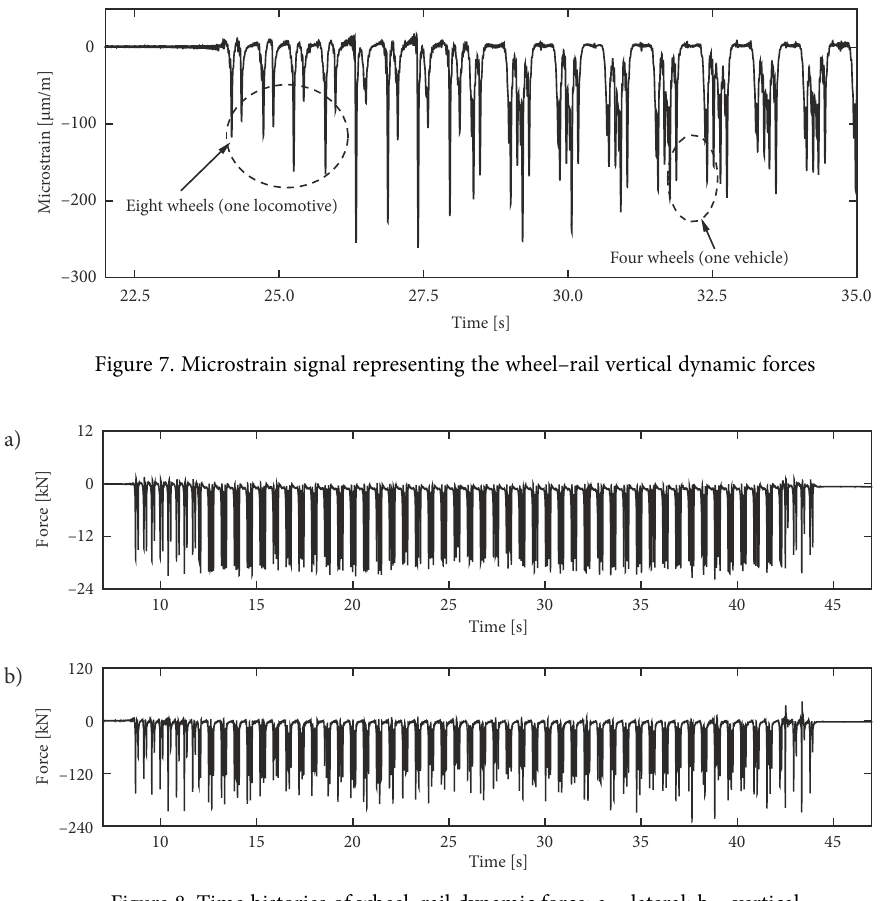
Figure 8. Time histories of wheel–rail dynamic force: a – lateral; b –